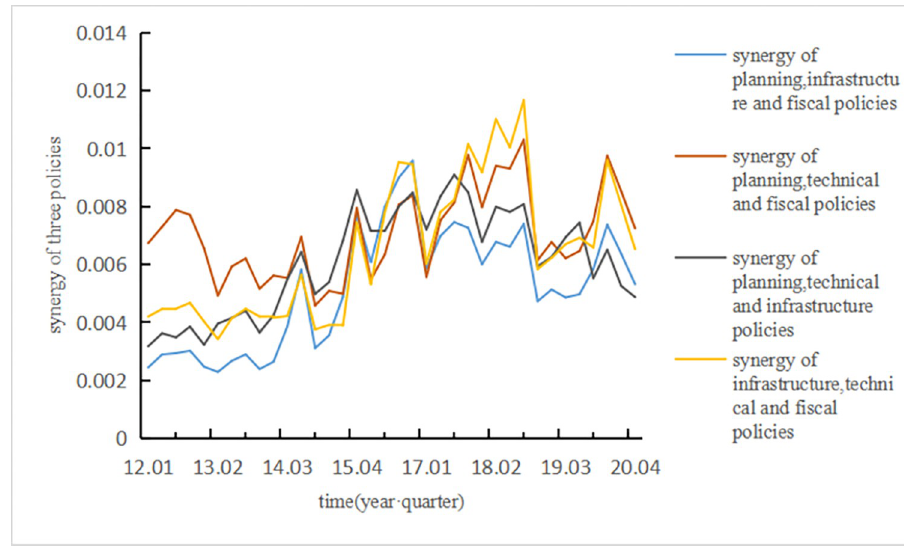
Fig 6. Synergy among three policy measures in each quarter from 2012 to